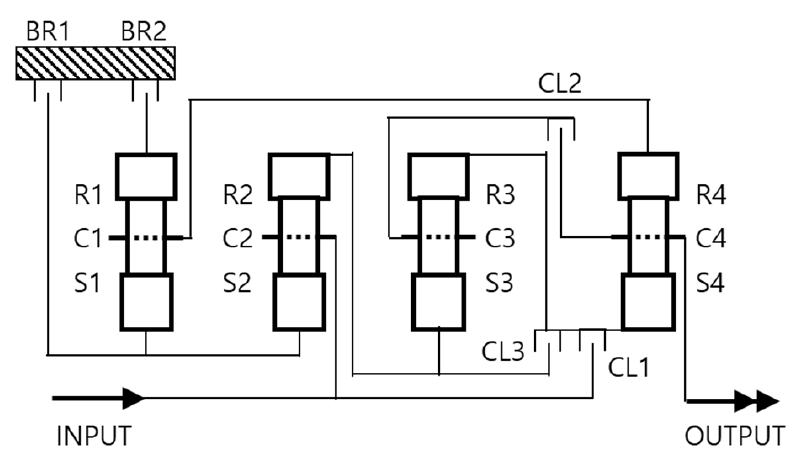
Figure 2. A schematic diagram of the transmission structure [28].